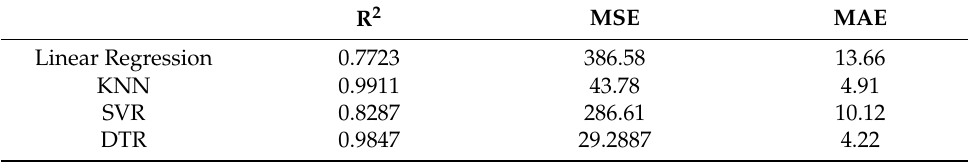
Table 9. Metrics for the selected models. Note: calculated based on test dataset. R